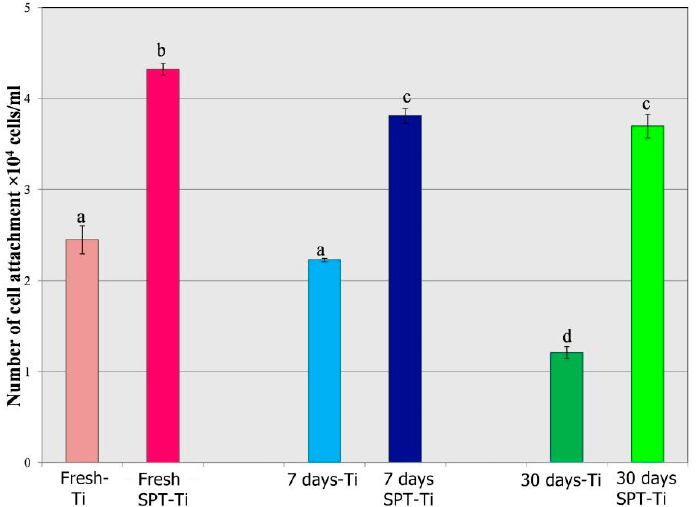
Figure 9. The number of attached cells on surfaces after 4 h incubation. The number of MC3T3E1 cells attached to the Polished ‐ Ti and Ti ‐ AT ‐ SPT with 0, 7, and 30 days aging in air is shown in the SEM and graph. Different letters in the graph mean statistical difference at p < 0.05.